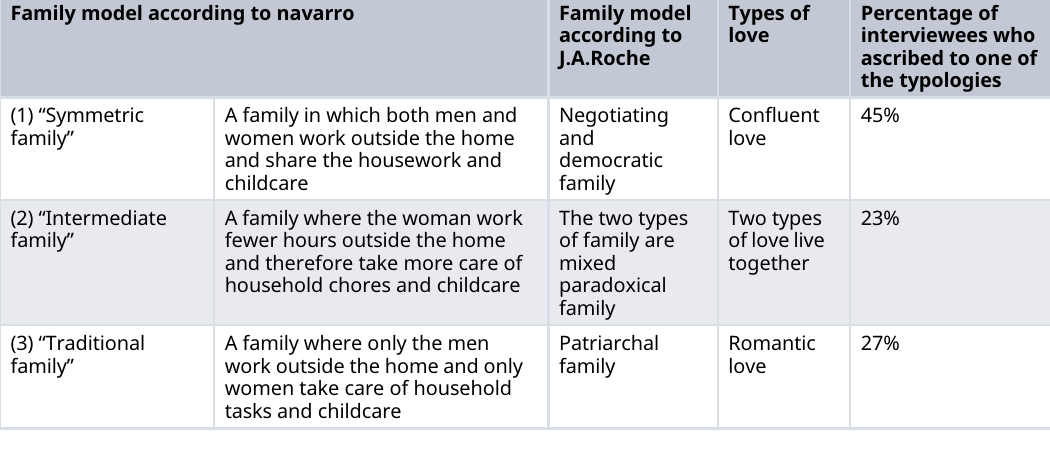
Table 4. A typology of Spanish families, based on the internal relations between parents and childrenand the parents ’ finalist values 5 . Source: Own elaboration based on Elzo 2004, p.220. N °